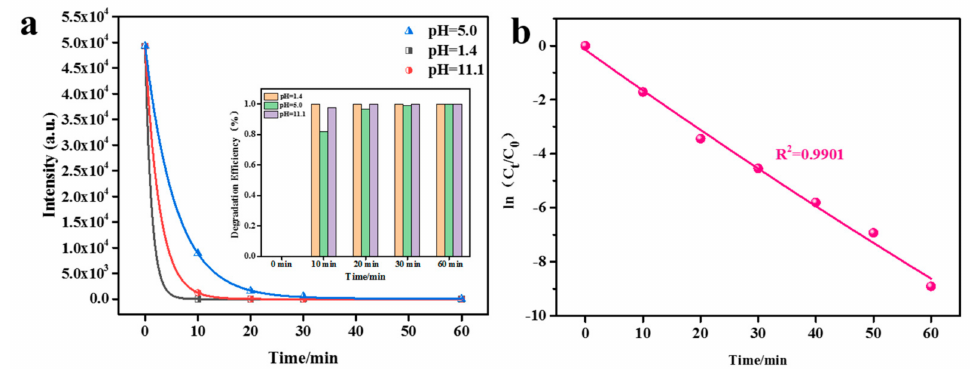
Figure 6. SERS intensity and efficiency (inset) diagrams of MB at band of 1623 cm − 1 catalyzed by MoS 2 /Au as a function of reaction time at different initial pH values ( a ); Kinetic fitting curve of SERS intensity of MB at band of 1623 cm − 1 as a function of reaction time ( b